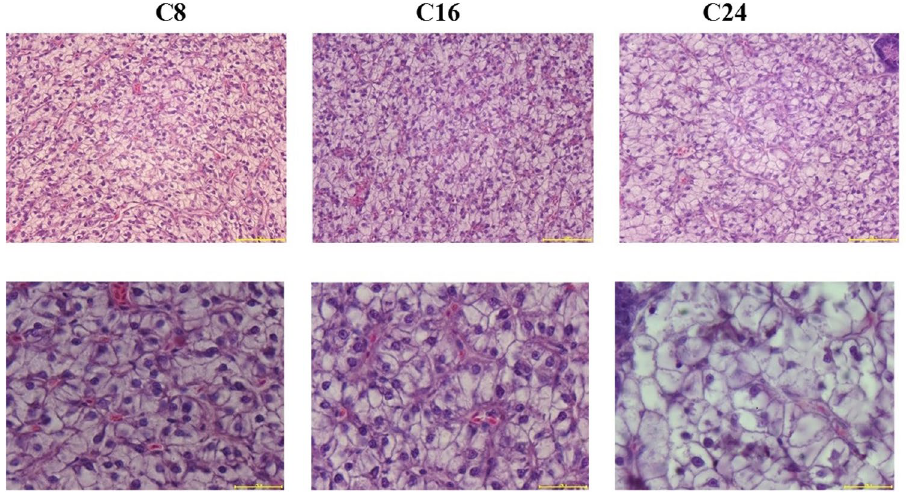
Figure 3. Effects of dietary carborhydrate levels on the hepatic histological characteristics of Japanese flounder after the 10-week feeding trial. Magnifications are × 400 (top) and × 1000 (bottom), and the scale bars are 20 μ m (top) and 50 μ m (bottom), respectively.